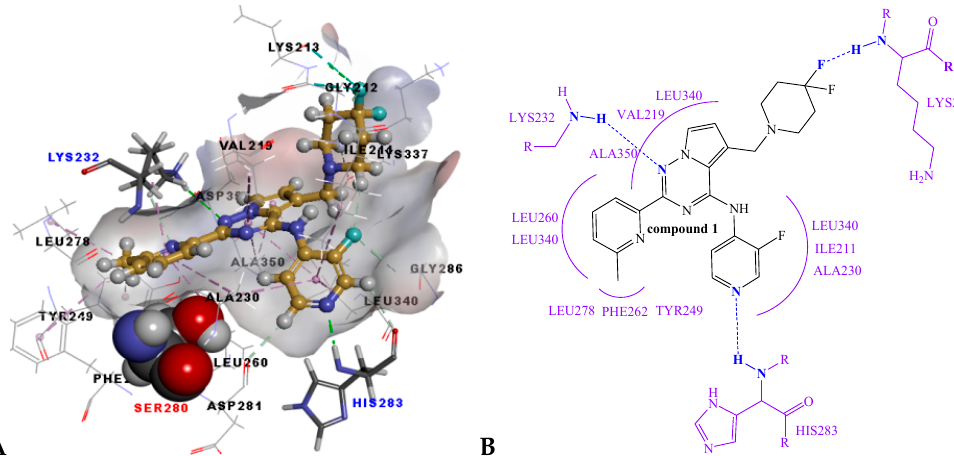
Figure 3. ( A ) The interpolated charge receptor surface (amino acid residue SER280 in the Corey-Pauling-Koltun model, amino acid residue LYS232 and HIS283 in the stick model, other amino acid residues in the line model and Compound 1 in the ball and stick model; the receptor surface colored by the interpolated atomic charge—blue represents a positive value and red represents a negative value); ( B ) the ligand–receptor interactions of Compound 1 shown as a 2D diagram—blue dotted lines represent hydrogen bindings and purple curved lines represent the frontiers of amino acid residues binding to Compound 1.